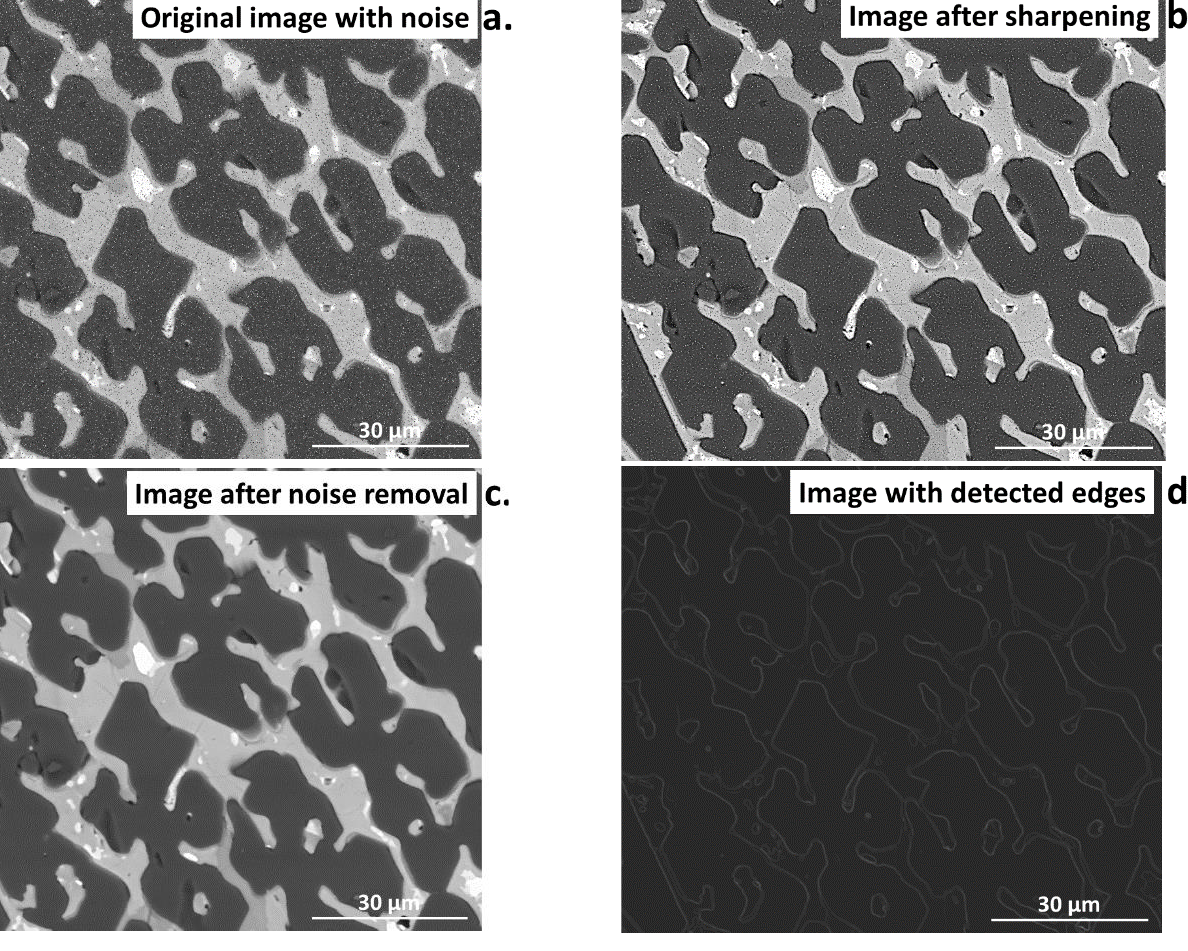
Figure 5. Comparison of the ( a ) input image with added noise, and images ( b ) after sharpening, ( c ) after noise removal, ( d ) with detected edges in the image without